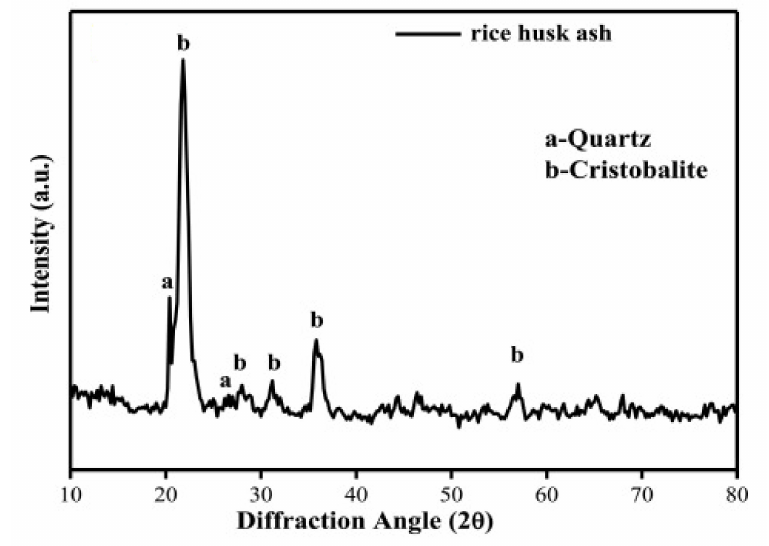
Figure 4. X-ray diffraction pattern of RHA. Adapted from the reference